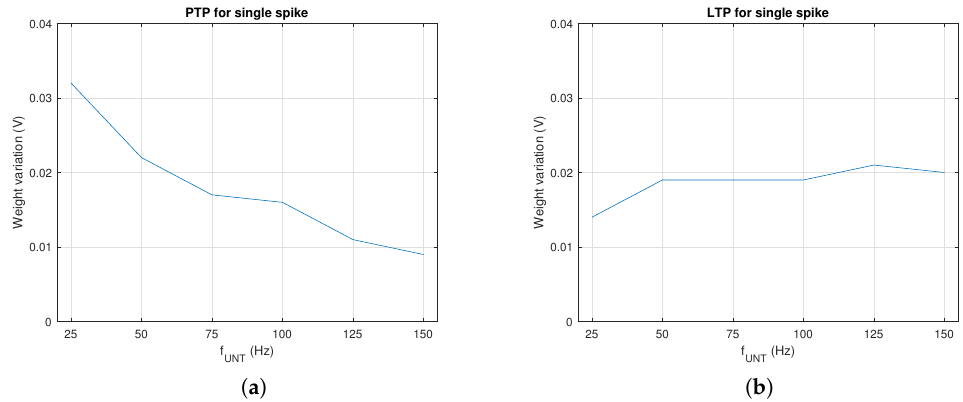
Figure 3. Weight variation with f pre during a single spike by ( a ) PTP and ( b ) LTP for a time window. Typically, the output frequency of an SNN depends on the number of pres that stimu- late post , as shown in Figure 4a. Starting from this observation, we determined dW LTP after 2 s of training for a different number of pres in PreNA UNT and PreNA T when f UNT = 75 Hz and f T = 100 Hz. Figure 4b–d show that dW LTP depended on the number of pres following different patterns for the trained and untrained neurons. In addition, the learning rate by LTP increased with the number of pres , mainly due to higher values of f POST determined by the activation of more pres .